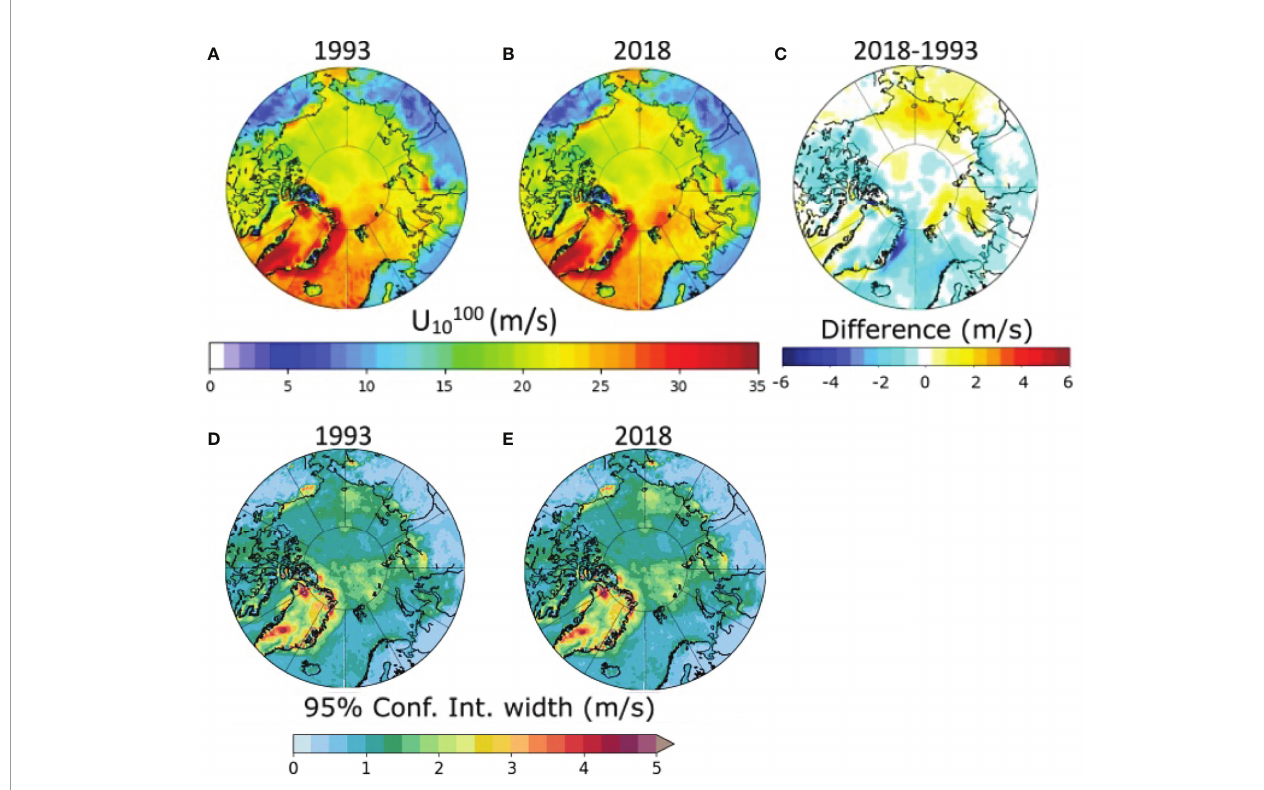
FIGURE 4 | ( U 100 10 ) (ms -1 ) obtained with a POT analysis (90 th percentile threshold) and a GPD distribution with the TS-EVA nonseasonal approach for (A) 1993 and (B) 2018. (C) The difference between estimates for 2018 and 1993. Width of 95% con fi dence interval for U 100 10 for (D) 1993 and (E)